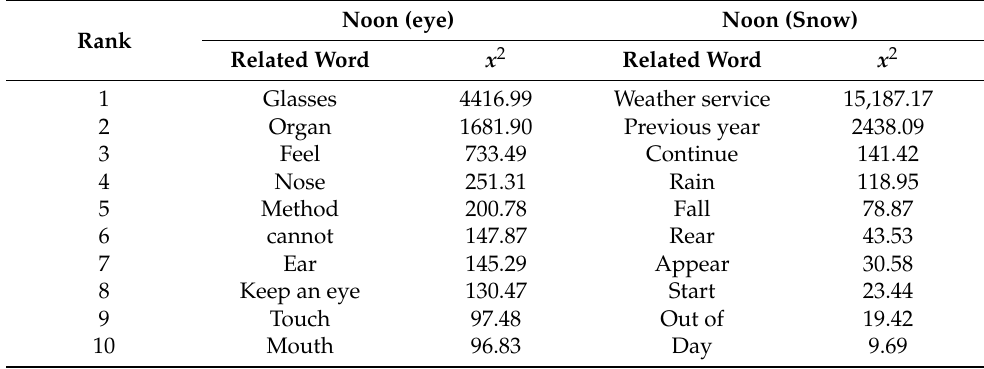
Table 6. Set of semantically related words of